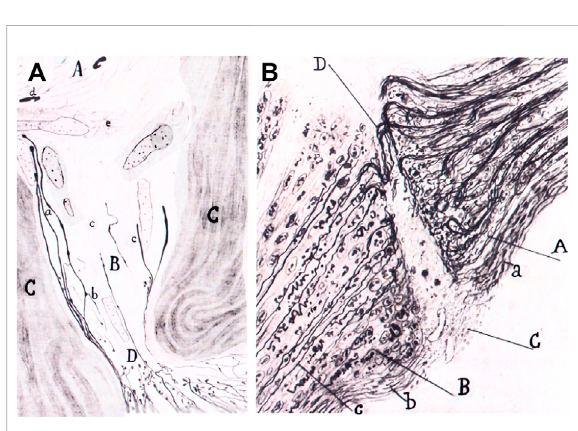
FIGURE 5 Graft of a piece of the sciatic nerve of a rabbit in the retinal area of the optic nerve. Portion of the sciatic nerve (A) ; degenerated part of the optic nerve (B) ; connective tissue of the optic nerve (C) ; strangulation of the optic nerve produced by the graft (D) ; new fi bers (a) ; collaterals going backwards (b) ; connective tissue invading the degenerated optic nerve. (B) . Same experiment.Sproutingsintheoptic nerve (A) ;portionofthesciatic nerve (B) ; scar (C) ; nerve sprouts crossing the scar (D) ; connective tissue of the optic nerve (a) : new neurilemma covering the graft (b) ; new fi ber reaching the graft (c) . Adapted from Tello, 1911; reproduced in Martínez-Tello,